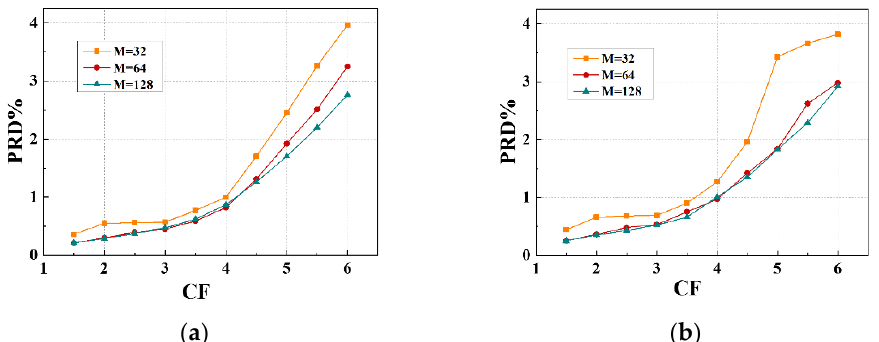
Figure 6. Reconstruction quality with various M and CF, ( a ) Records 101; ( b ) Records 102.